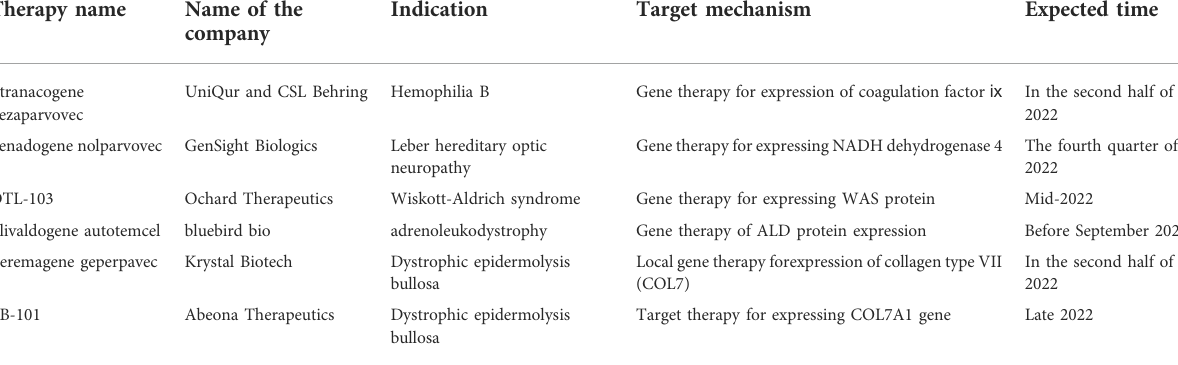
TABLE 2 List of gene therapies expected to gain ground in rare diseases in